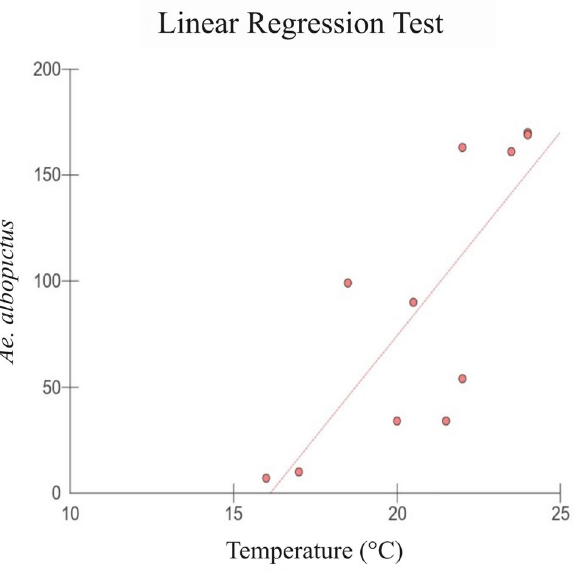
Figure 2. Linear regression test graph of Ae. albopictus related to temperature (ºC), in Córrego da Luz Municipal Park, in the city of Casimiro de Abreu, Rio de Janeiro state,